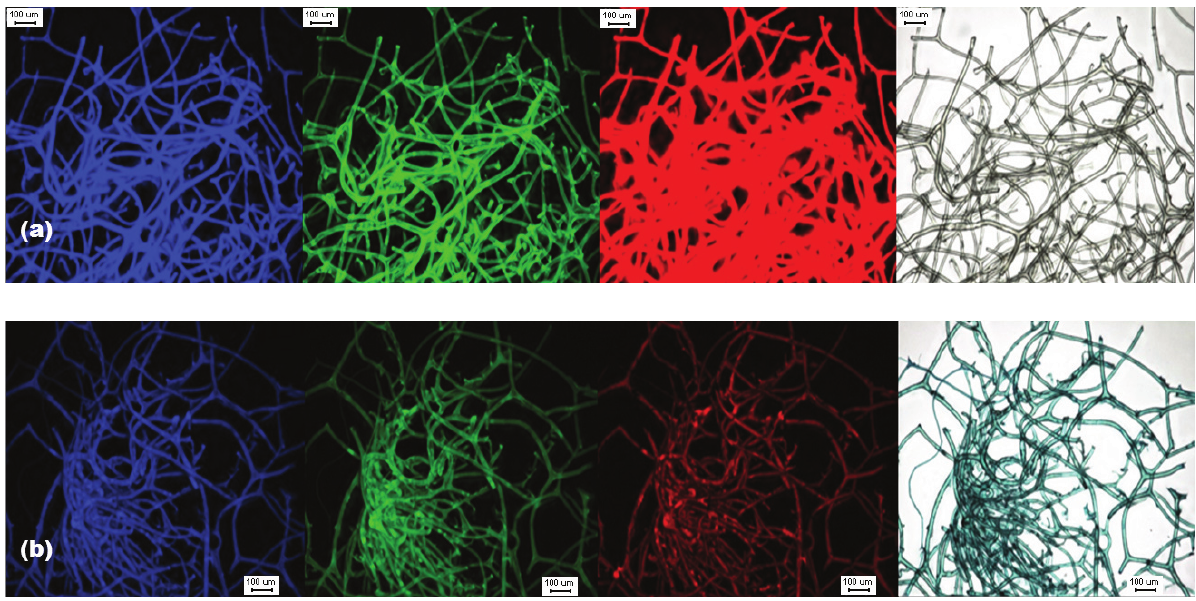
Figure 6: Images of H. communis fibrous skeleton (a) and CuPC- Hc S (b) from fluorescent and light